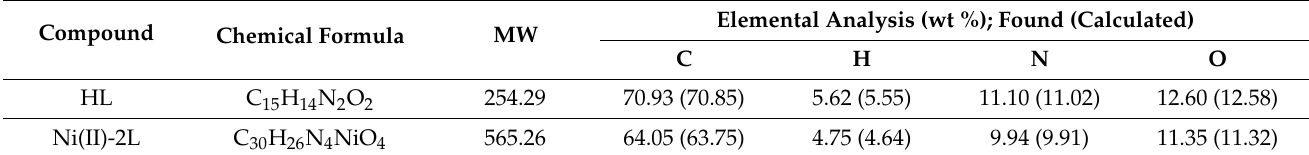
Elemental Analysis (wt %); Found (Calculated)